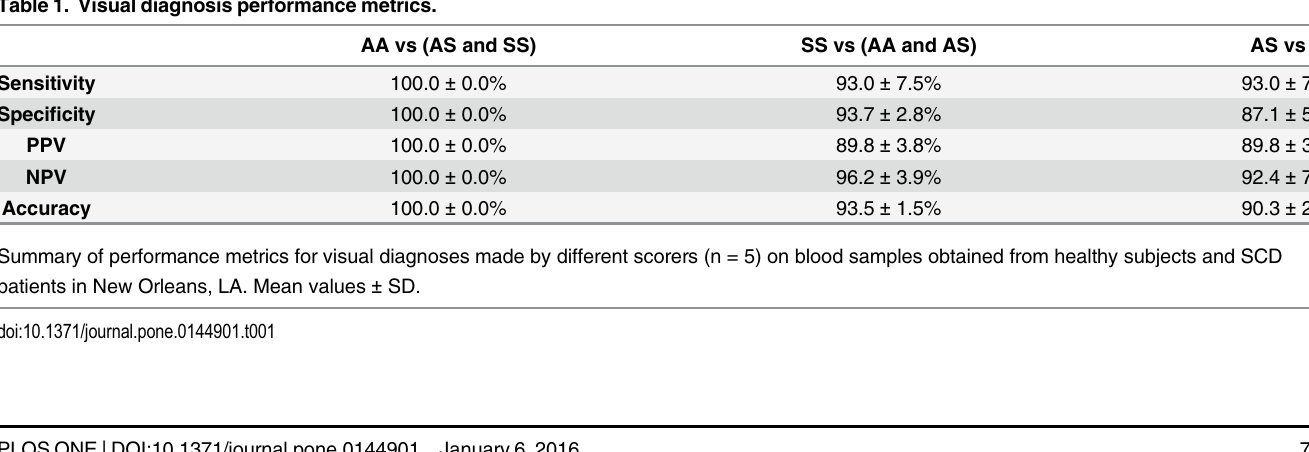
Table 1. Visual diagnosis performance metrics.